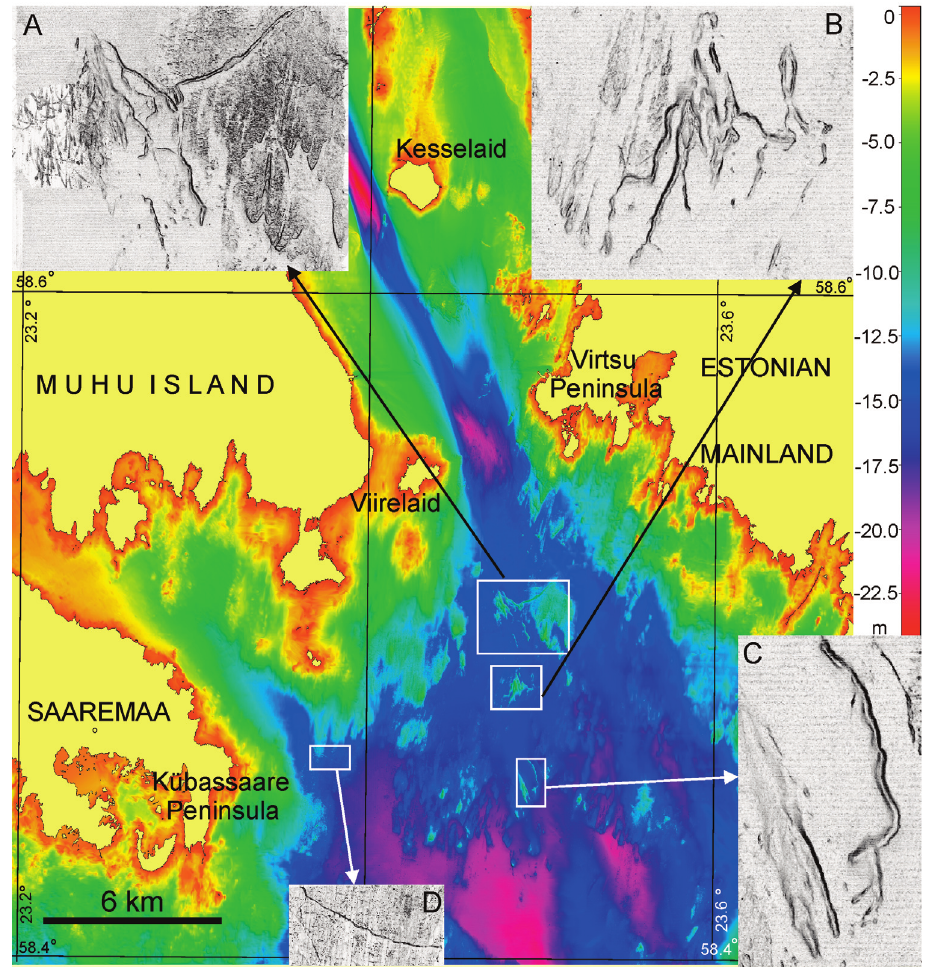
Fig. 9. Eskers/esker fields (with enlargements) exposed on the bathymetry map of the NW corner of the Gulf of Riga. The map/ enlargments were compiled by the Estonian Maritime Administration using the multibeam